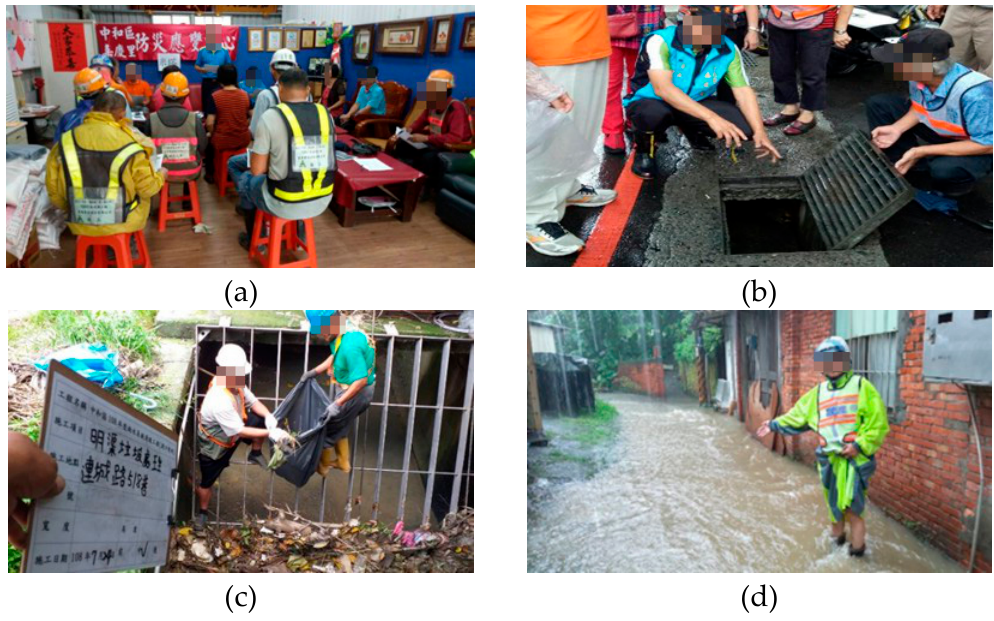
Figure 5. ( a ) Preparedness meeting; ( b ) patrolling the drainage system; ( c ) cleaning the drainage system with district cleaning contractor; ( d ) identifying and recording the flooding situation for future